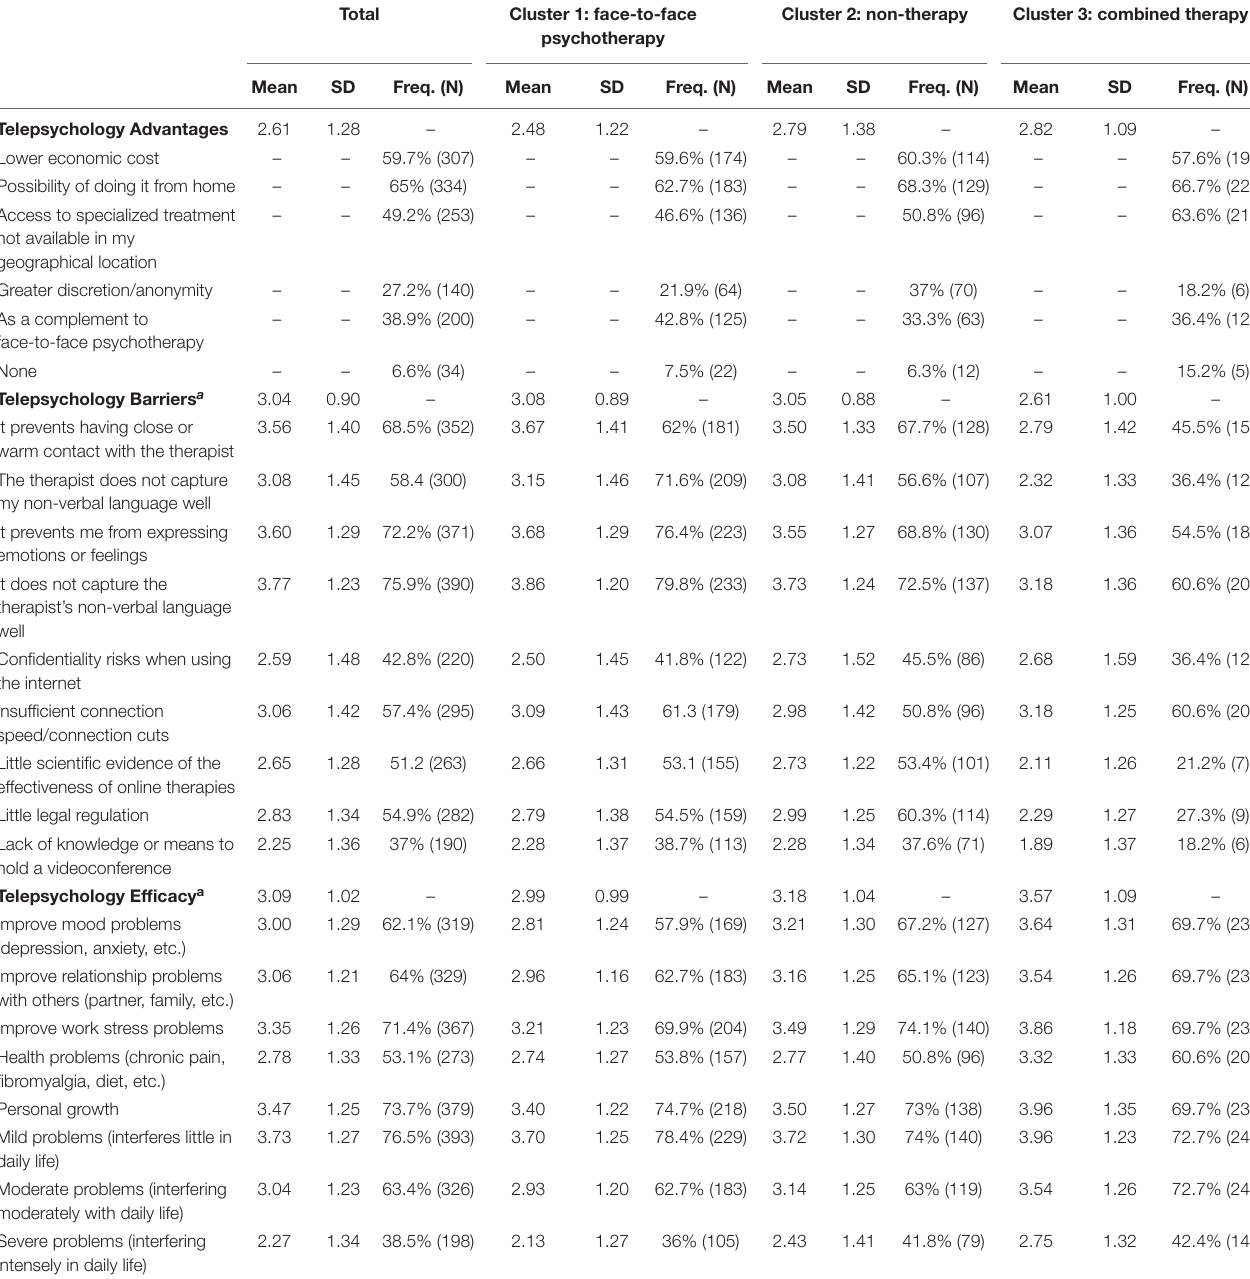
TABLE 2 | Descriptive and frequency analysis of perception of telepsychology: advantages, barriers, and efficacy. Total Cluster 1: face-to-face Cluster 2: psychotherapy